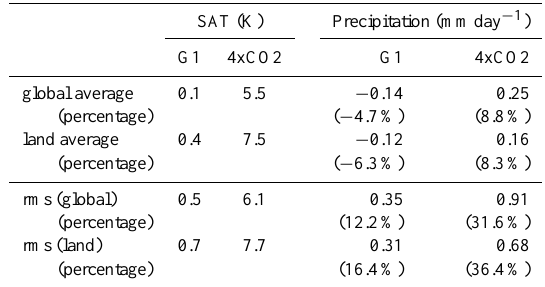
Table 5. Comparison of multi-model mean responses to the forcings in G1 and abrupt4xCO2 simulations, respectively, with respect to piControl. Responses are calculated for the individual models both in terms of spatially averaged differences and in terms of root mean square differences, and then averaged over the four ESMs. RMS differences are calculated after interpolation of the results from the individual models to a 192 × 96 grid. Besides global mean values, also averages over land surface only are